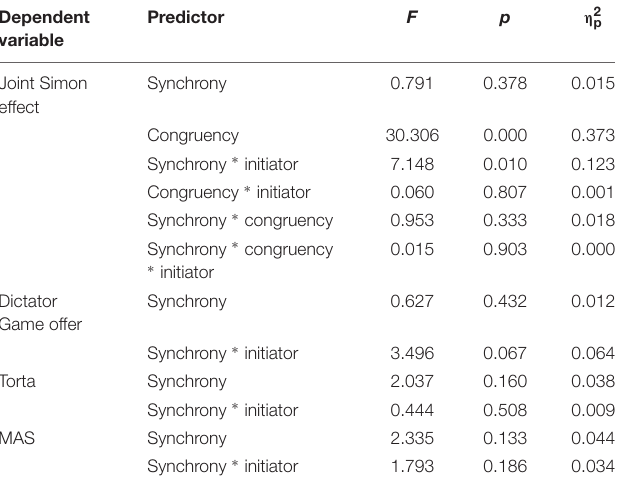
TABLE 2 | Results for all mixed ANOVAs. TABLE 3 | Bayes Factors for inclusion of specified terms compared to models without those